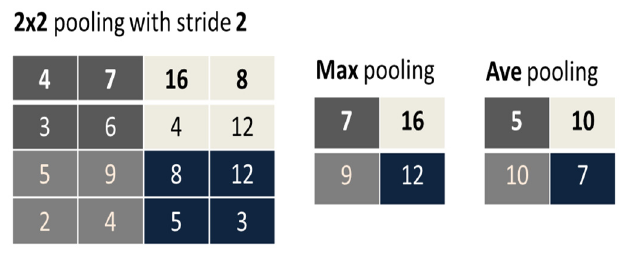
Figure 3. Two most popular pooling